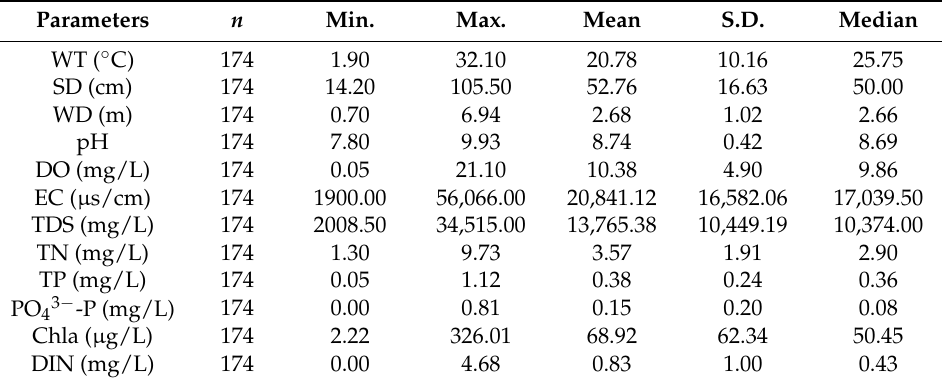
Table 2. Key statistics of the water quality parameters in the Duliujian River.